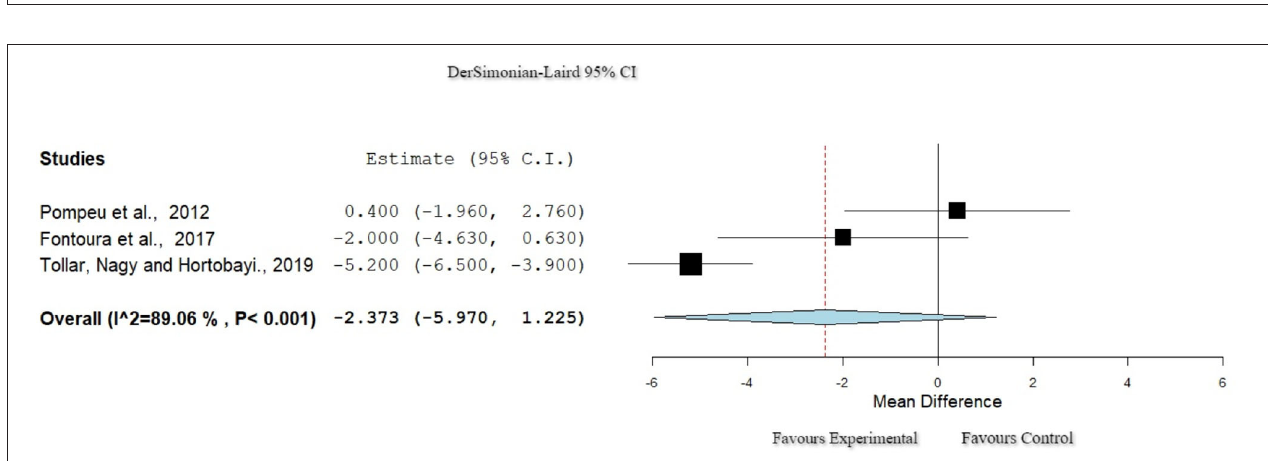
FIGURE 3 | Forest plot for ADL: ABC. The red dash line represents the weighted mean difference of the included studies. The blue figure represents the weighted 95% CI of the included studies. ABC, Activities-Specific Balance Confidence Scale; ADL, activities of daily living.